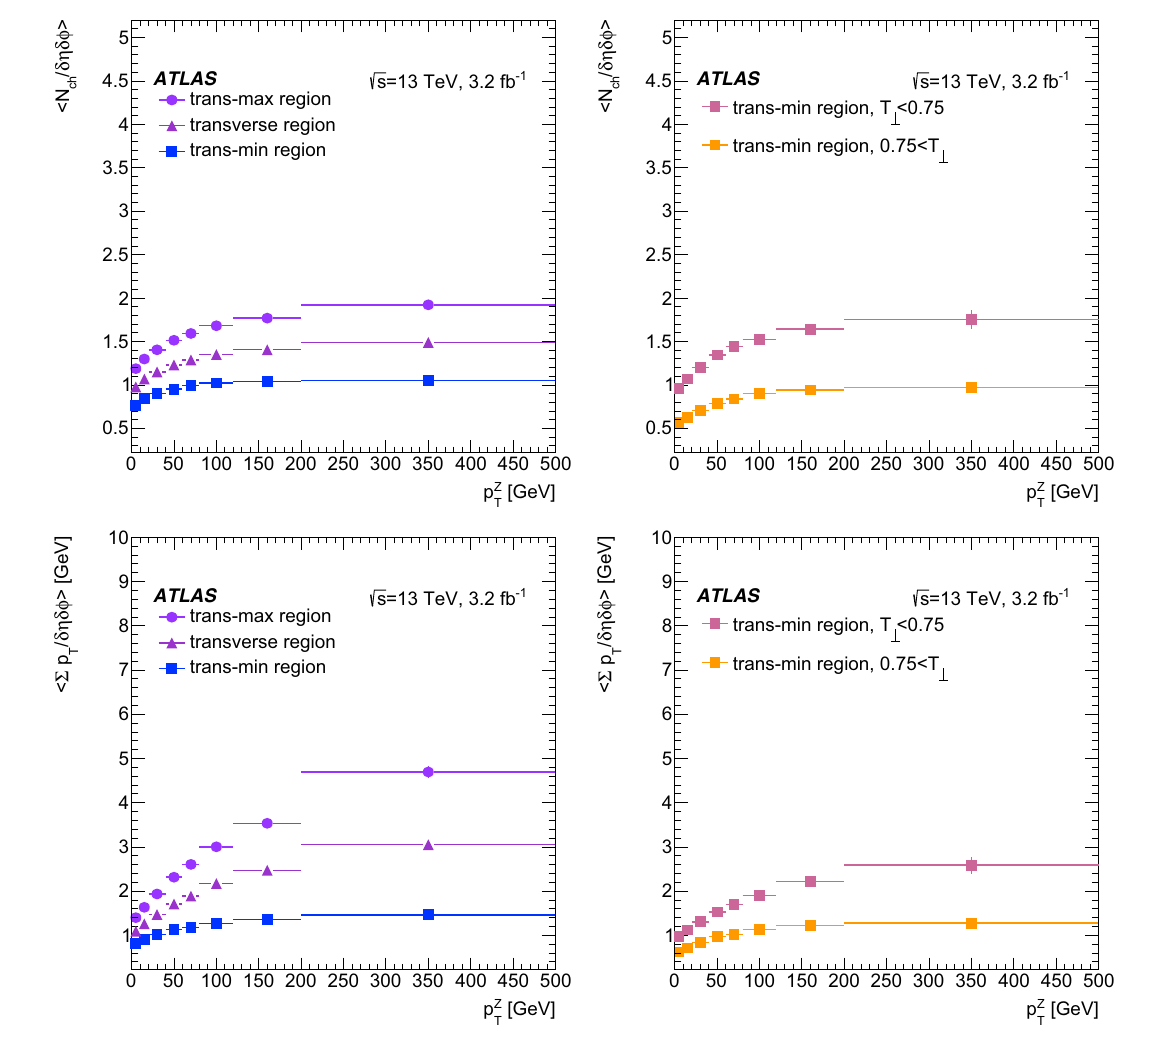
Fig. 8 Themeannumberofchargedparticles(upperrow)andthemean and for the trans-min and trans-max regions inclusively in T ⊥ (left) and of the scalar sum of the transverse momentum of those particles (lower in the trans-min region separated in T ⊥ row) per unit η – φ space as a function of p Z in the full transverse region T